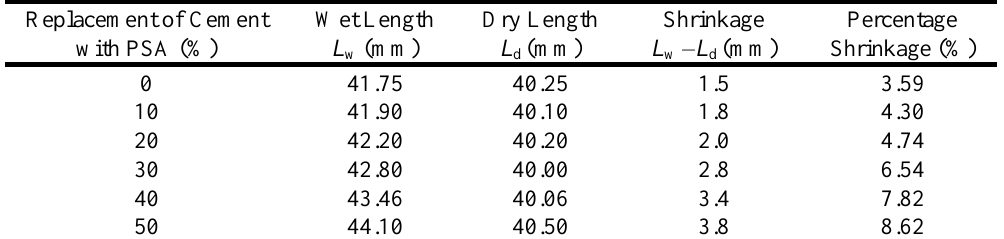
Table 9. Shrinkage of Lateritic Block (developed by the authors, based on the conducted survey) Replacement of